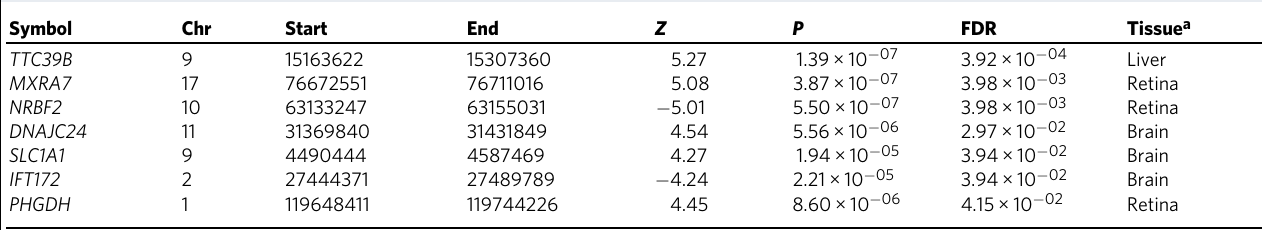
Table 4 TWAS results in tissues relevant for